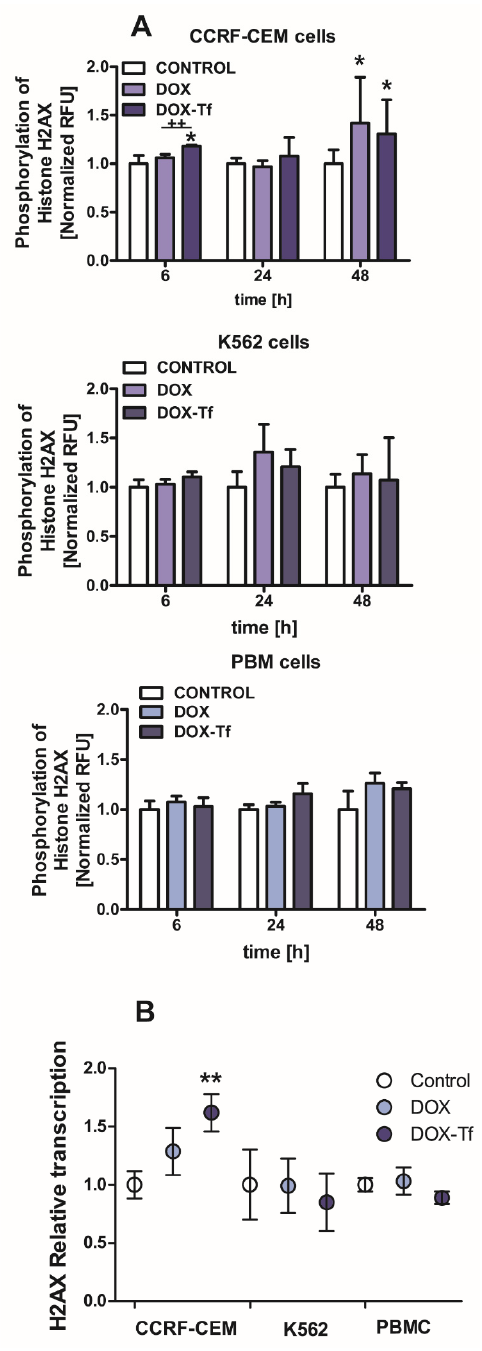
Figure 2. Doxorubicin–transferrin conjugate induced modifications of histone H2AX in human leukemia cells ( A ):The ratio of phosphorylation of histone H2AX ( γ H2AX) in comparison to total cellular content of this protein after treatment of CCRF-CEM and K562 cells or PBMCs with IC 50 concentrations of doxorubicin (DOX) alone and doxorubicin–transferrin (DOX–Tf) conjugate for 6, 24, or 48 h. All values were normalized to untreated control cells, taken as 1. Data are expressed as the means ± SD, ( n = 3). * p < 0.05 indicates statistically significant di ff erence compared with control cells; and ++ p < 0.01 shows a di ff erence of γ H2AX level between cells treated with DOX or DOX–Tf. ( B ): The level of mRNA transcripts for the histone H2AX gene in the examined human leukemia cell lines as well as PBMCs exposed to IC 50 concentrations of free DOX or DOX–Tf for 24 h. Data are expressed as the means ± SD, ( n = 3). Asterisks refer to the level of significant di ff erence (** p < 0.01) in mRNA level in the conjugate-treated cells compared to untreated control